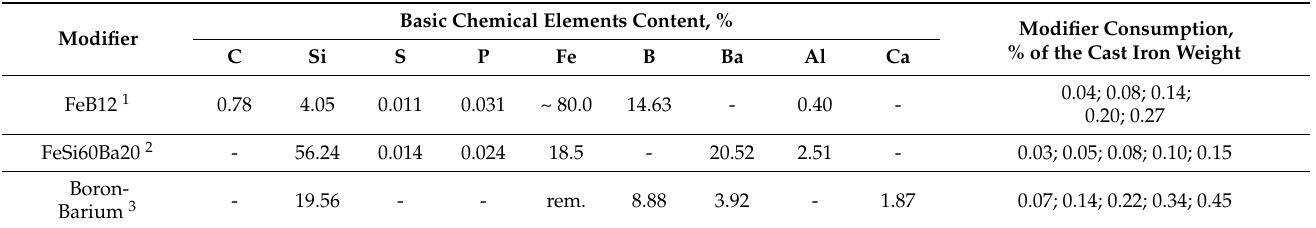
Table 1. Chemical composition and consumption of modifiers used, %. Basic Chemical Elements Content, %